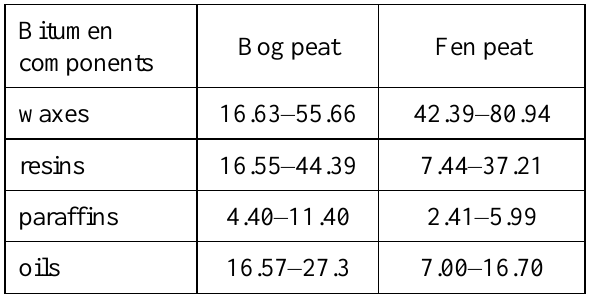
Table 1. Composition of peat bitumens (%). F rom